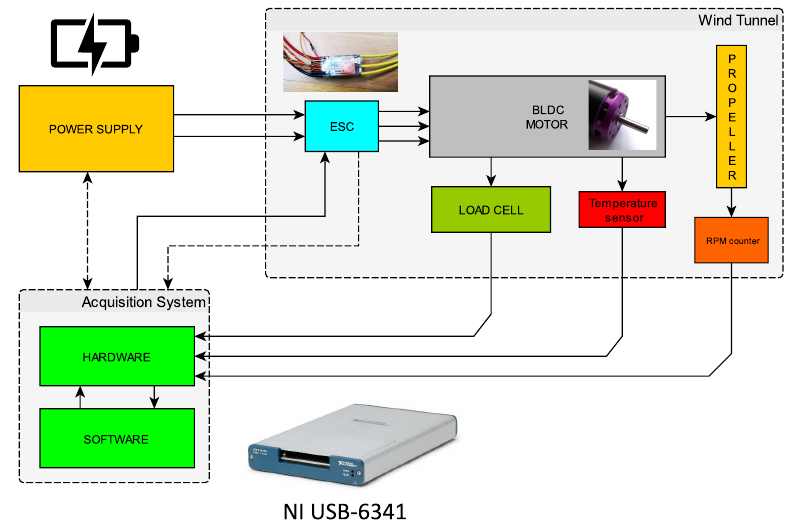
Figure 8. Scheme of the wind tunnel system for propulsive tests.